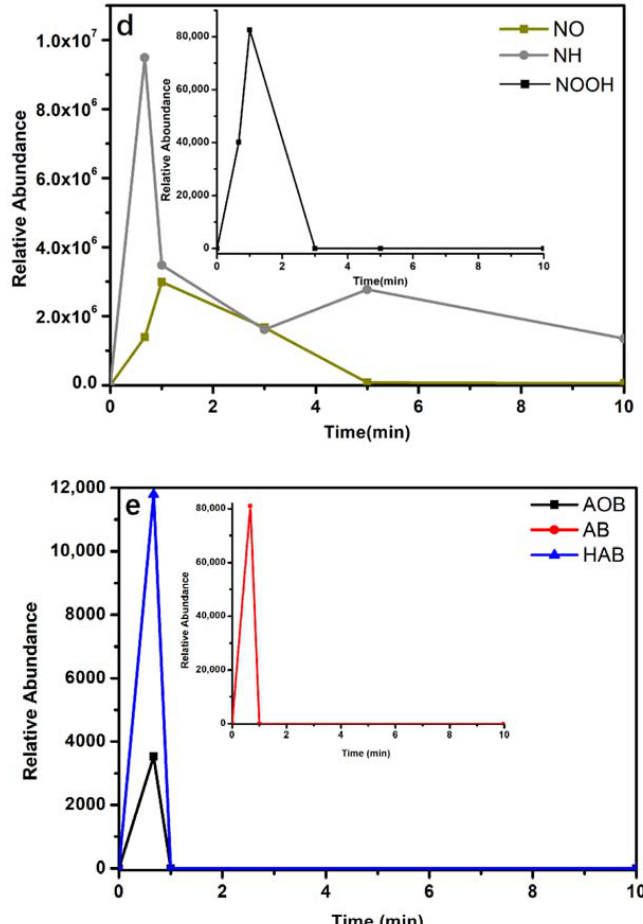
Figure 3. Integrated spectra ( a ) UV–visible absorption spectra of the same molarity of 4 ‐ NP ion and 4 ‐ AP and ( b – e ) the relative abundance curves versus time of the intermediates captured at key time node of Solution 2 during the hydrogenation of 4 ‐ NP.